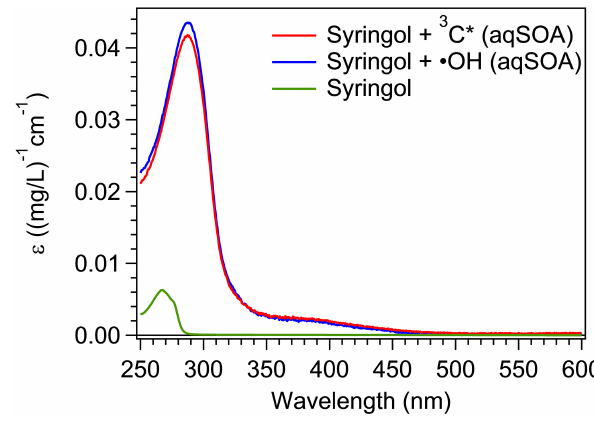
Figure 10. UV–visible spectra of syringol and syringol aqSOA formed in 3 C ∗ -mediated and · OH-mediated aqueous-phase reac- tions. The aqSOA spectra were corrected for absorbance contribu- tions from unreacted reactants (syringol and